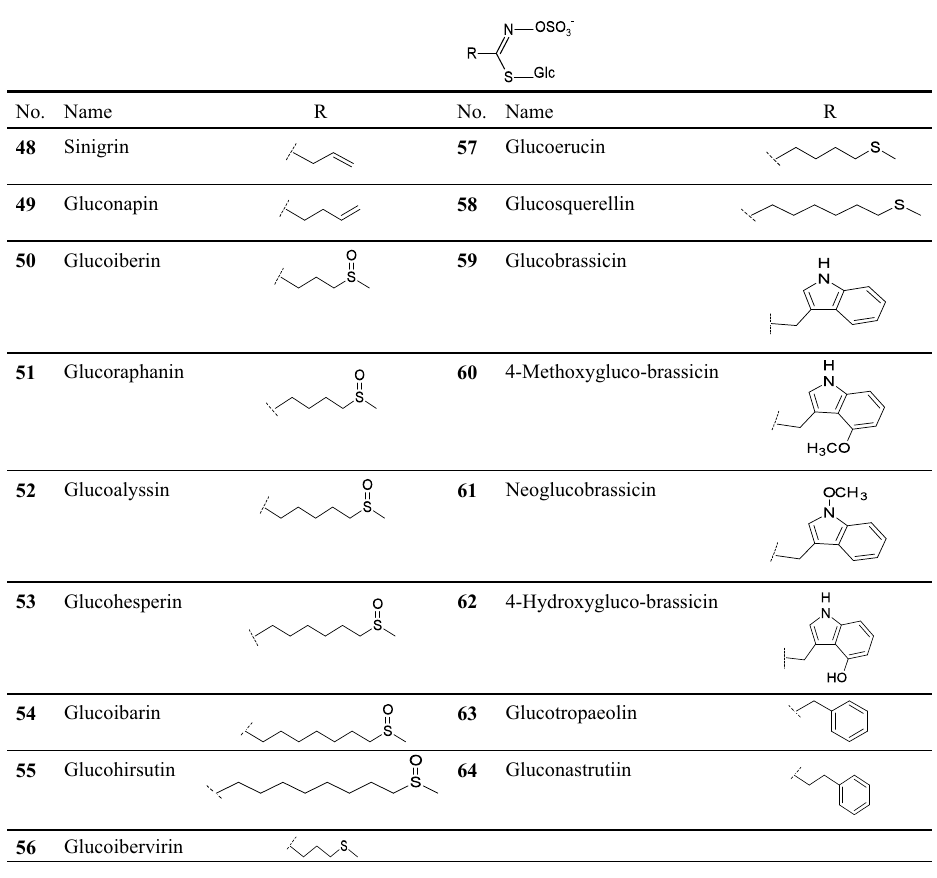
Fig. 7: Different side groups (R) of some glucosinolates ( 48 - 64